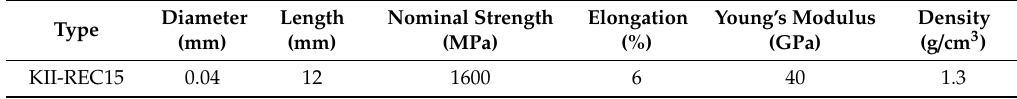
Table 1. Properties of polyvinyl alcohol (PVA)